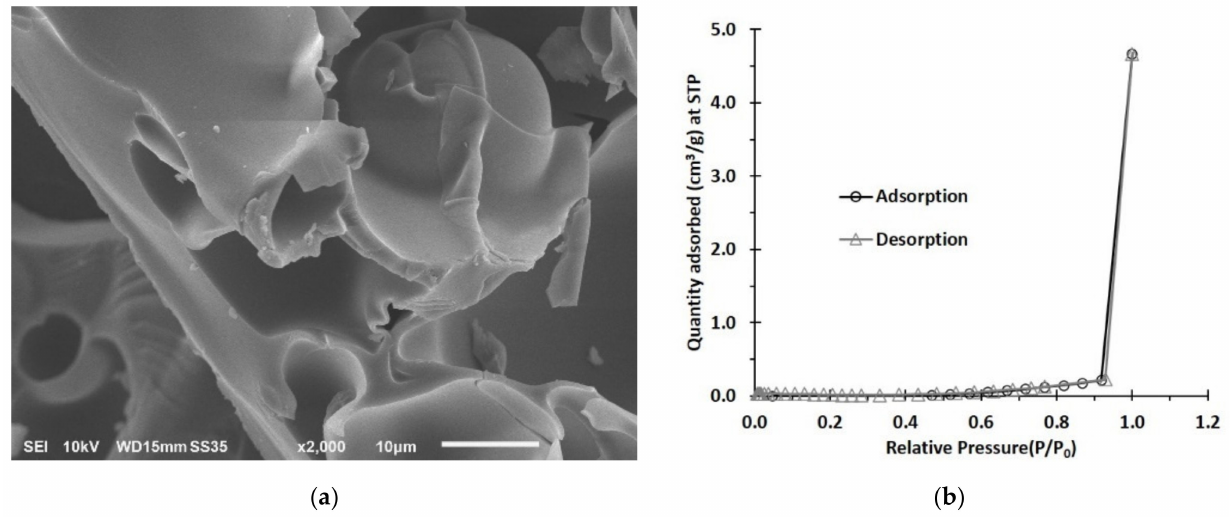
Figure 3. ( a ) SEM image of C10D-P2 nanosponges ( b ) BET isotherm plot of C10D-P2 nanosponges.